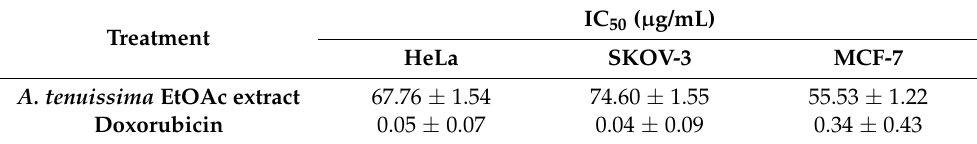
Table 1. IC 50 values of A. tenuissima extract and doxorubicin for tested cancer cell lines.